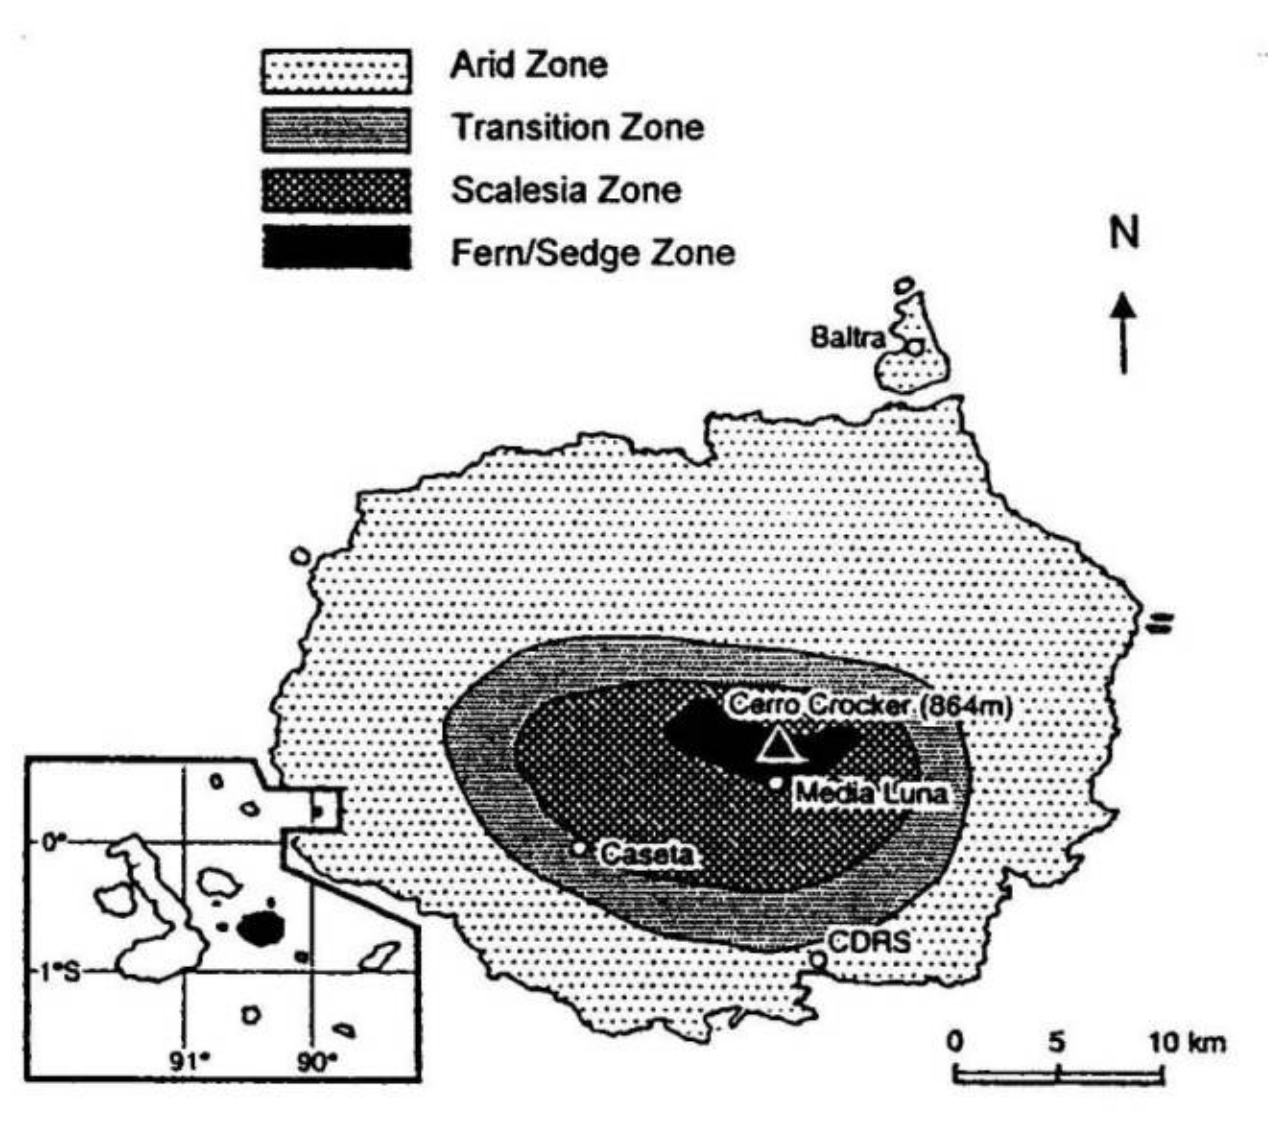
Fig. 1. Vegetation zones on the island of Santa Cruz, Galapagos. The Scalesia forest and fern–sedge zones collectively comprise the Humid Zone. Inset figure of Santa Cruz (in black) within the context of the main Galapagos islands. Adapted from Itow